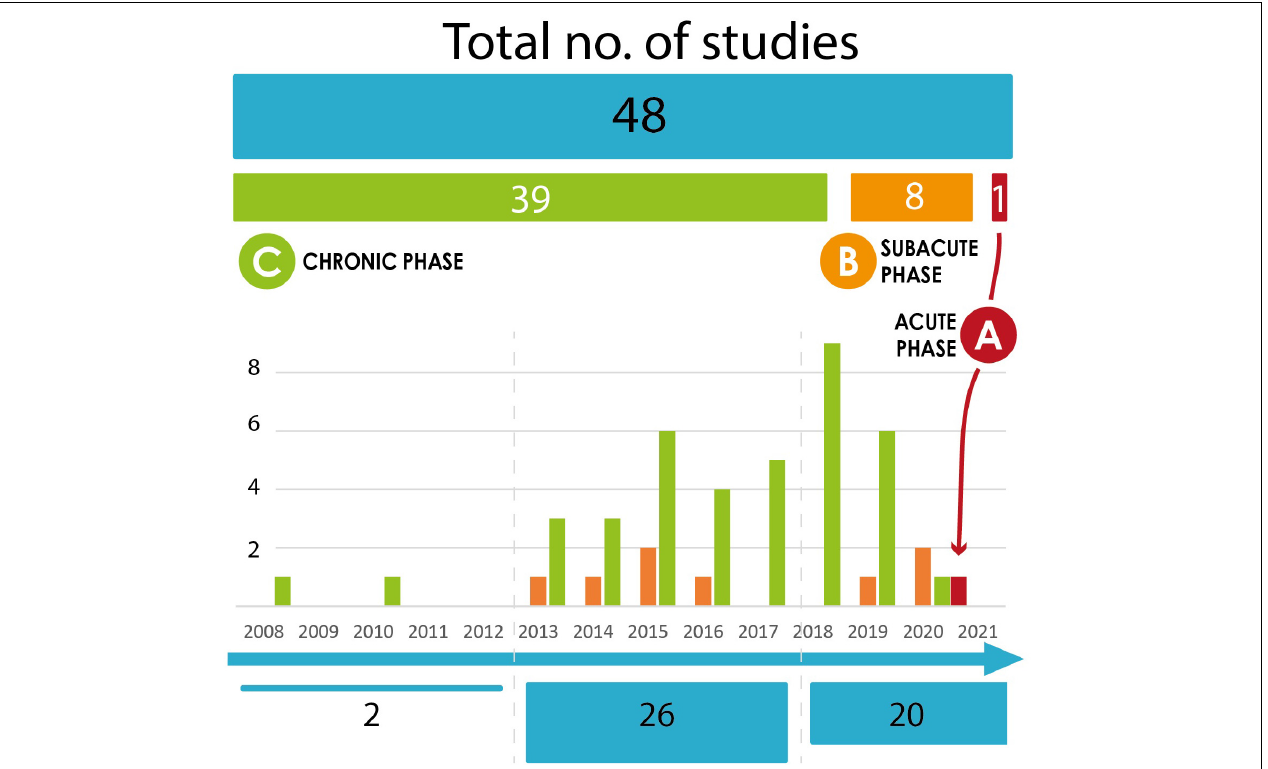
FIGURE 3 | Evolution of NFB studies in the literature. Number of NFB studies in stroke population according to the time since the stroke. The studies included in the graph are those cited in the main meta-analyses since 2018 (Carvalho et al., 2019; Bai et al., 2020; Kruse et al., 2020; Baniqued et al., 2021). (A) Acute phase. (B) Subacute phase. (C) Chronic